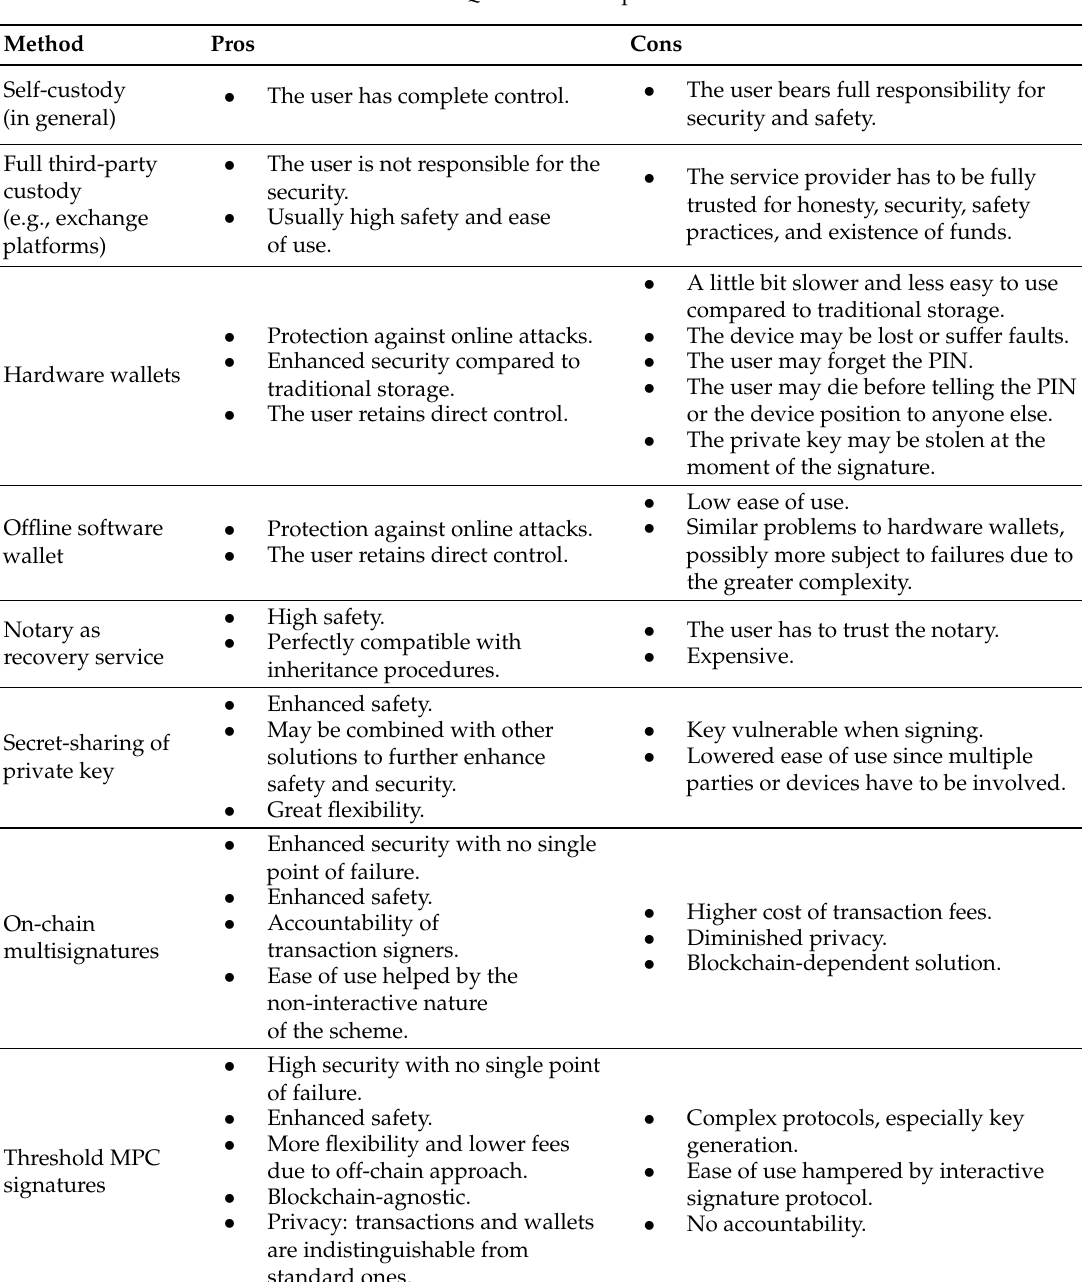
Table 1. Qualitative